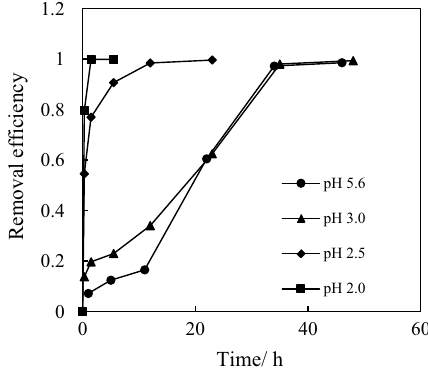
Fig. 1 Effect of pH on Cr(VI) reduction by